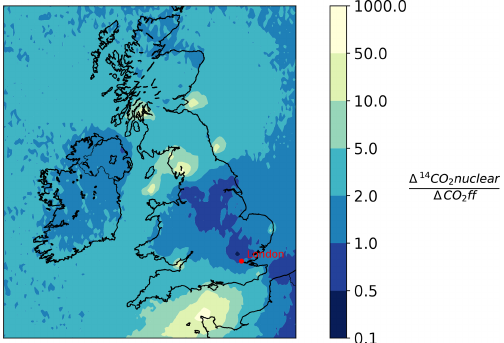
Figure 6. This figure shows the ratio of modelled 14 CO 2 nuclear values ( 14 CO 2 nuclear) to modelled fossil fuel CO 2 values (CO 2 ff) in the UK and Ireland. The values represent yearly averages, calcu- lated with a 1-year (June 2012–June 2013) forward run performed in NAME. CO was used as a proxy for ffCO 2 and the conver- sion factor (5.7ppbppm − 1 ) was used to convert CO to CO 2 (see Sect. 5). High values in yellow represent regions with a large in- fluence from nuclear 14 CO 2 emissions compared to the fossil fuel emissions, whereas darker blue areas with a lower 14 CO 2 / ffCO 2 ratio represent areas where the influence from fossil fuel emissions on (cid:49) 14 CO 2 is larger than the influence from nuclear